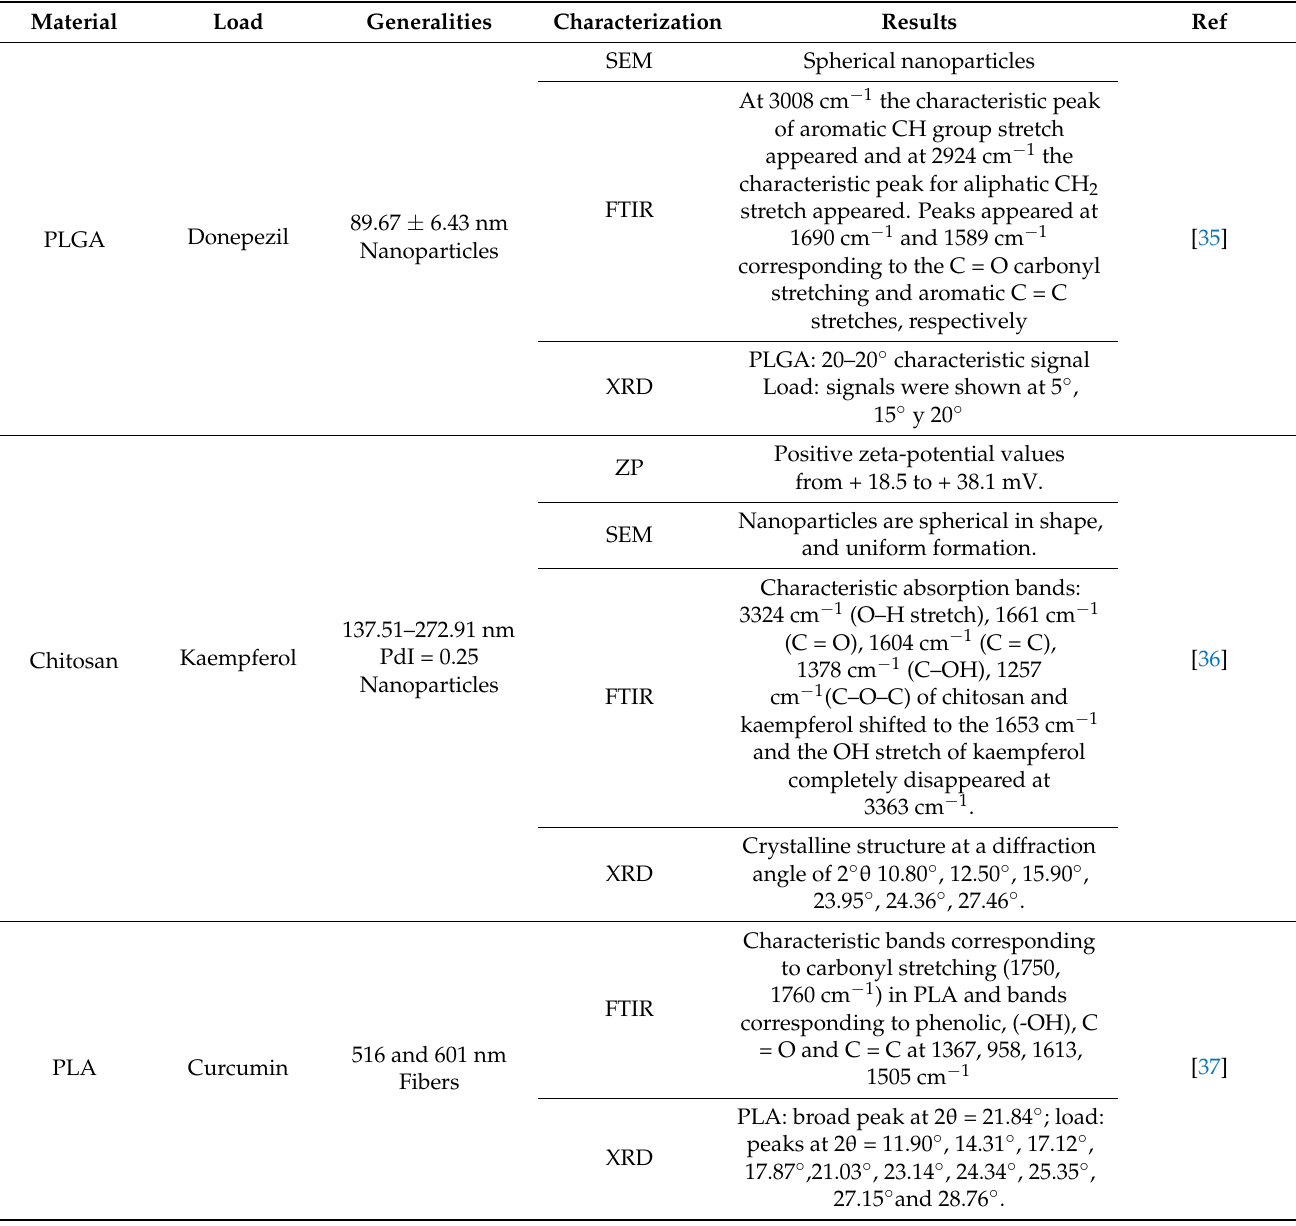
Table 1. Biofunctionalized materials and relevant information on characterization